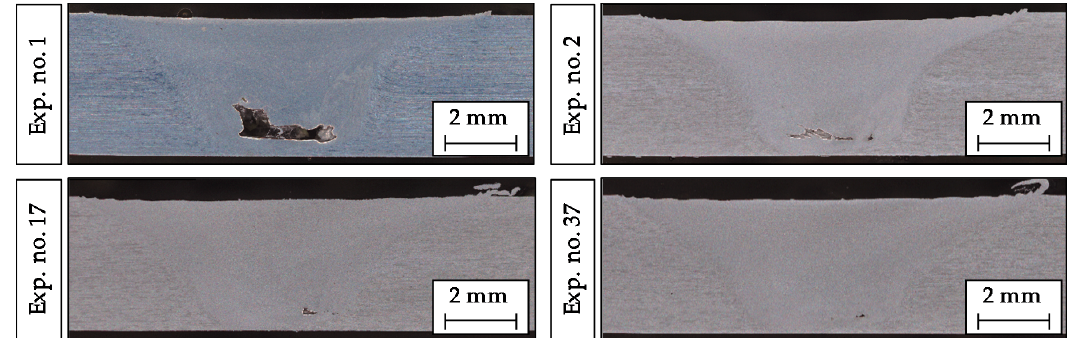
Figure 3. Cross-sections of the experiments 1, 2, 17, and 37 (cf. Appendix) with visible internal